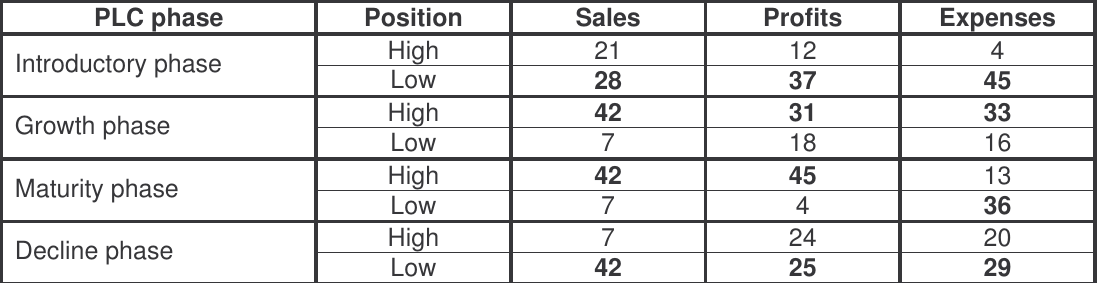
Frequency distribution of high and low positioning of sales, profits